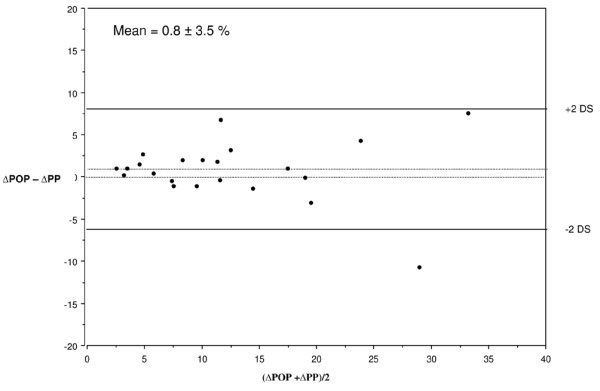
Bias and precision of ΔPP estimated from ΔPOP (Bland–Altman analysis). ΔPOP, respiratory variations in POP waveform amplitude; ΔPP, respiratory variations in systemic pulse pressure.